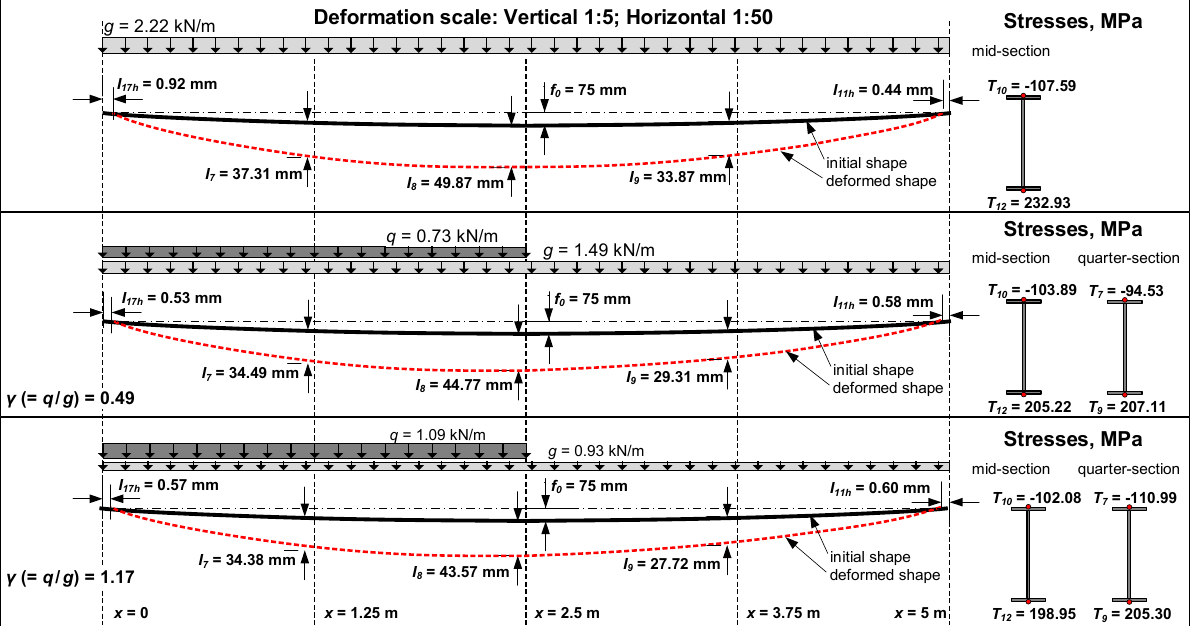
Figure 7. Monitoring results of the bridge Model-2 .